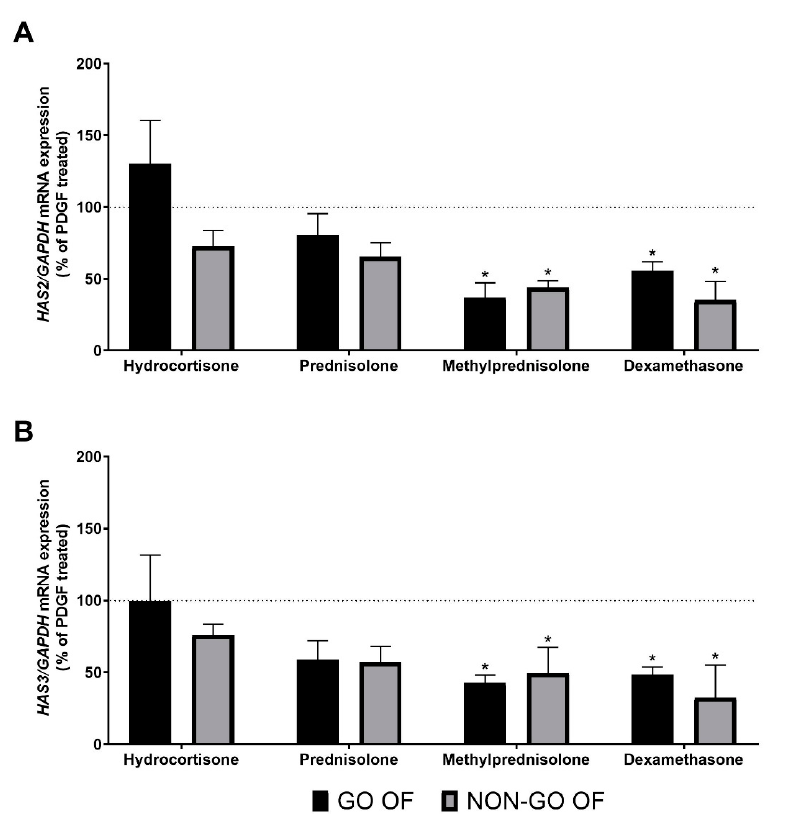
Figure 4. The effect of GCs (1 µ M) on ( A ) HAS2 and ( B ) HAS3 mRNA expression after PDGF-BB treatment. The dotted line represents the mRNA expression of PDGF-BB stimulated cultures. Data were analyzed using a repeated measure ANOVA followed by Dunnett’s test. Result shown are the mean ± SEM. * p < 0.05. GO OF—Graves’ orbitopathy fibroblasts, NON-GO OF—control orbital fibroblasts, DF—dermal fibroblasts, HAS2 —hyaluronan synthase 2, HAS3 —hyaluronan synthase 3, GAPDH —glyceraldehyde 3-phosphate dehydrogenase.